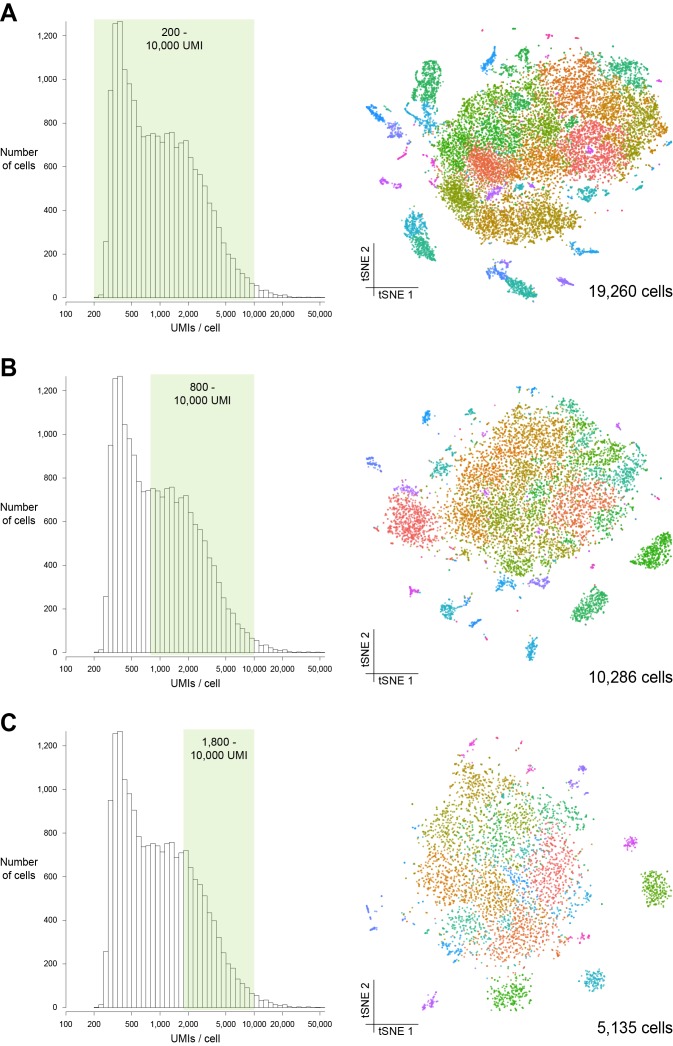
– Comparison of different quality filters.(A–C) Left: histograms representing the distribution of numbers of UMIs per cell selected with cutoffs of 200 (A), 800 (B) and 1800 (C) UMIs per cell. Right: t-SNE plots of the same data set as in Figure 1B. obtained with these cutoffs to compare the impact of number of cells and UMI coverage on t-SNE clusters.